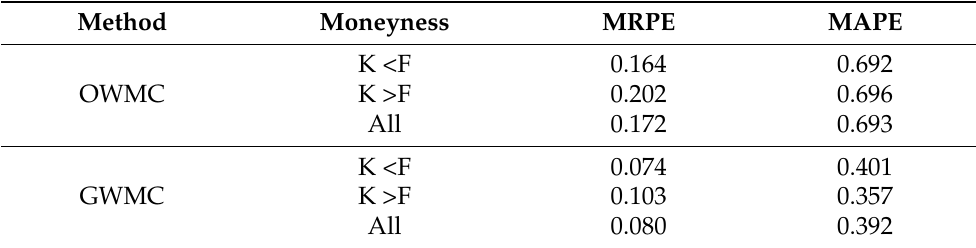
Table 7. Intertemporal run results for the OWMC method and the GWMC method using the Heston model as an initial model for OTM puts (K <F) and OTM calls (K